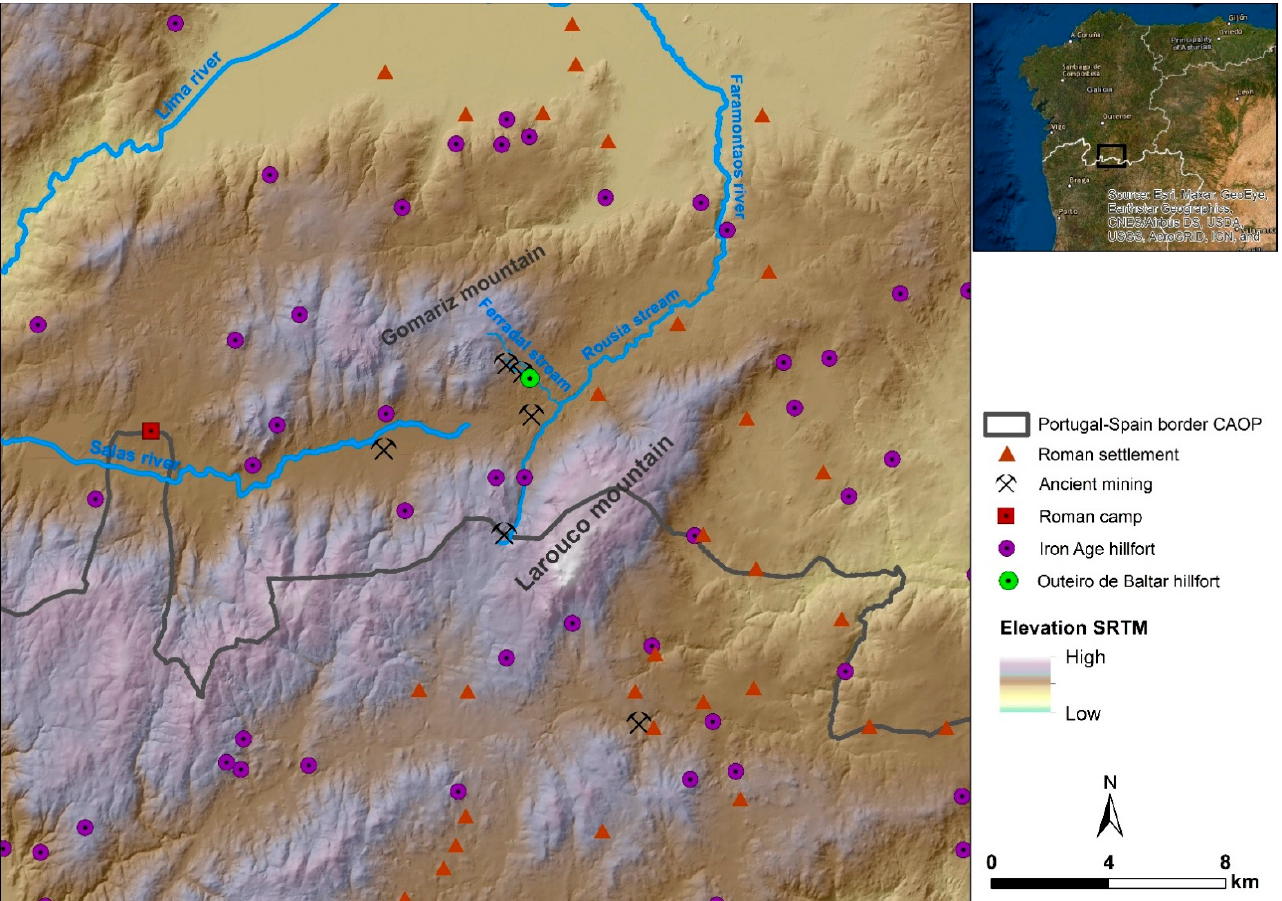
Figure 1. Archaeological landscape of the surroundings of the Outeiro de Baltar hillfort, with location of other Iron Age hillforts, ancient mining sites, Roman settlements and one military camp.